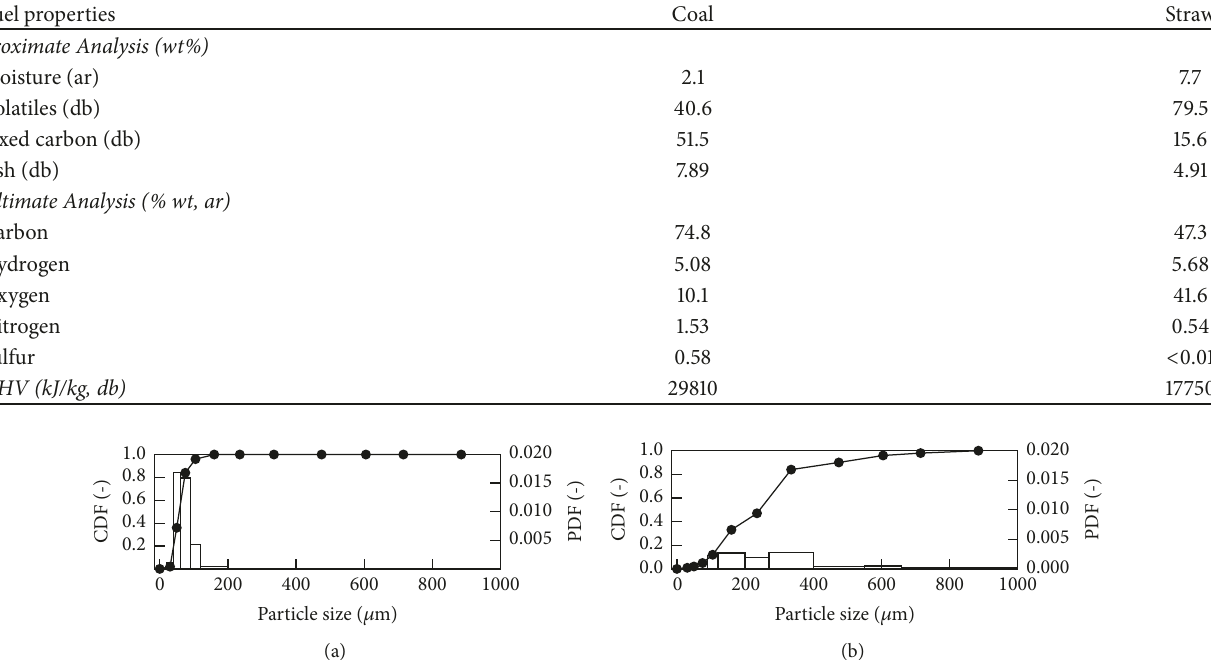
Figure 2: Particle size distribution represented by cumulative distribution function (CDF) and probability density function (PDF): (a) coal; (b)